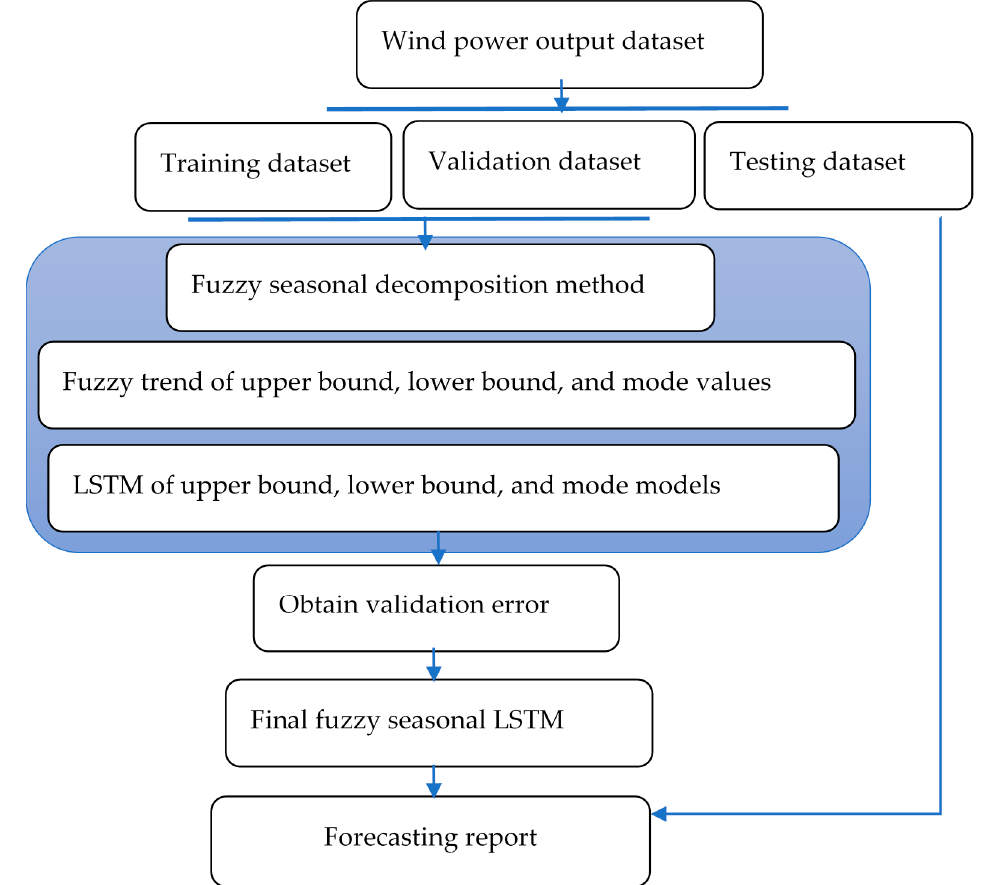
Figure 1. A flowchart of the fuzzy seasonal LSTM prediction model.